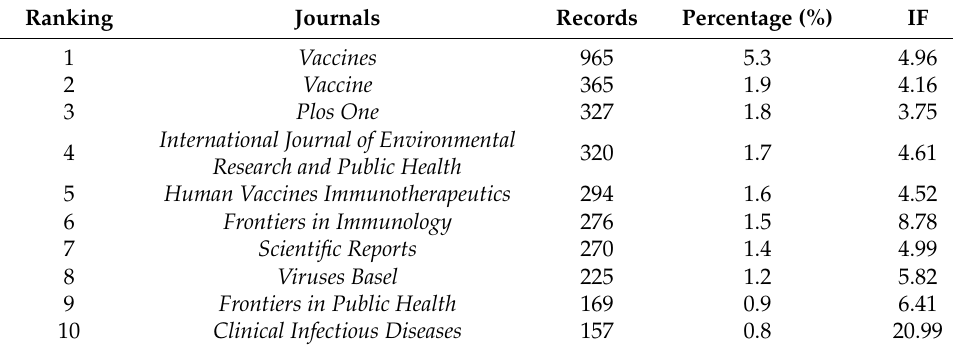
Table 4. Top 10 most prolific journals on COVID-19 vaccine